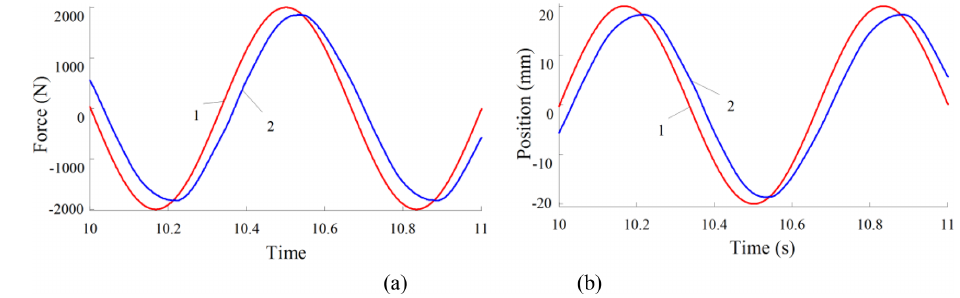
Figure 18. Real-time response curves of 1.5Hz. Real-time change curves of (a) driving force and (b) position.